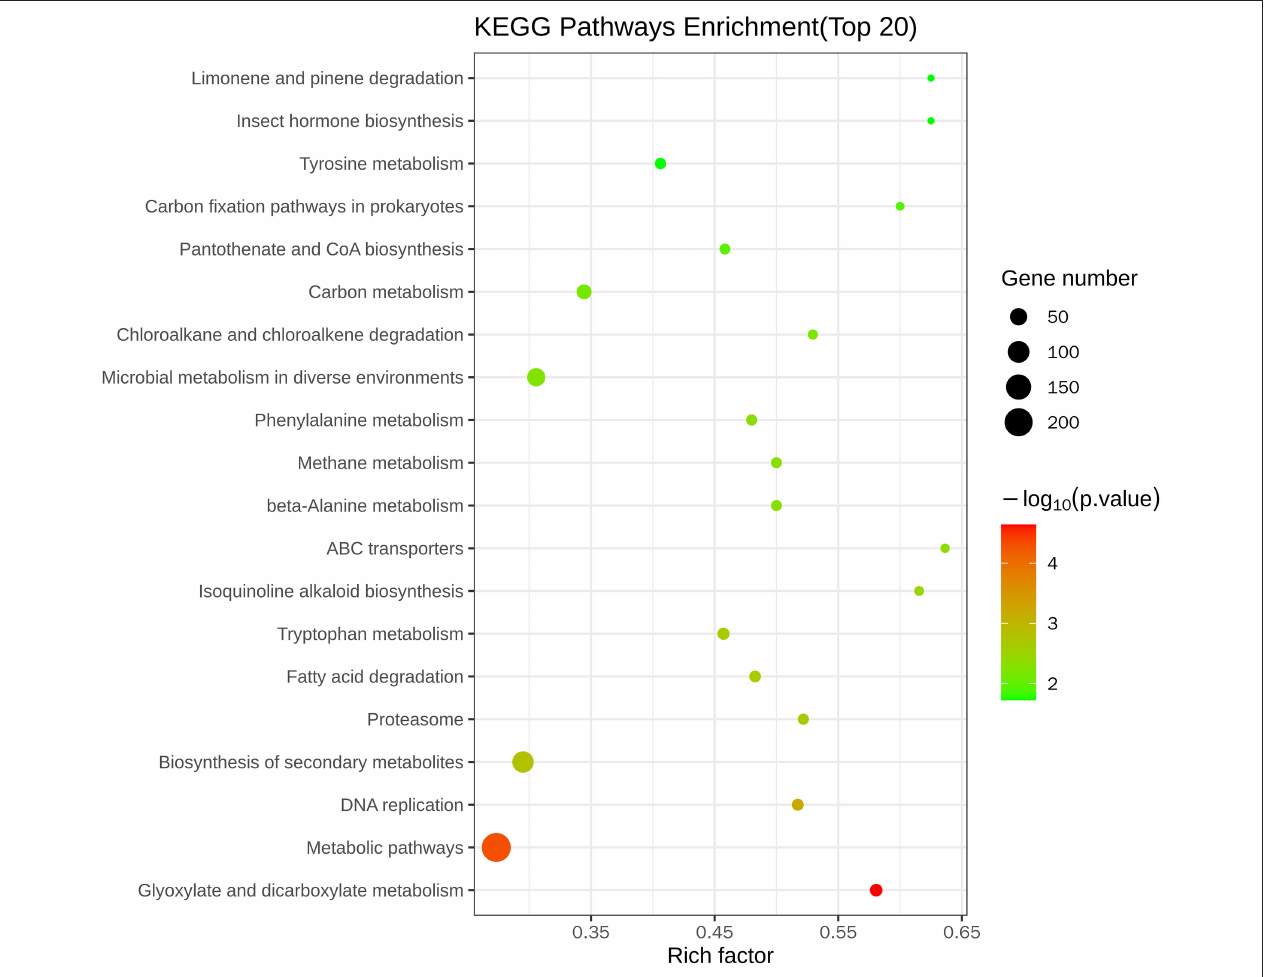
FIGURE 5 | Top 20 KEGG enrichment pathways of differentially expressed